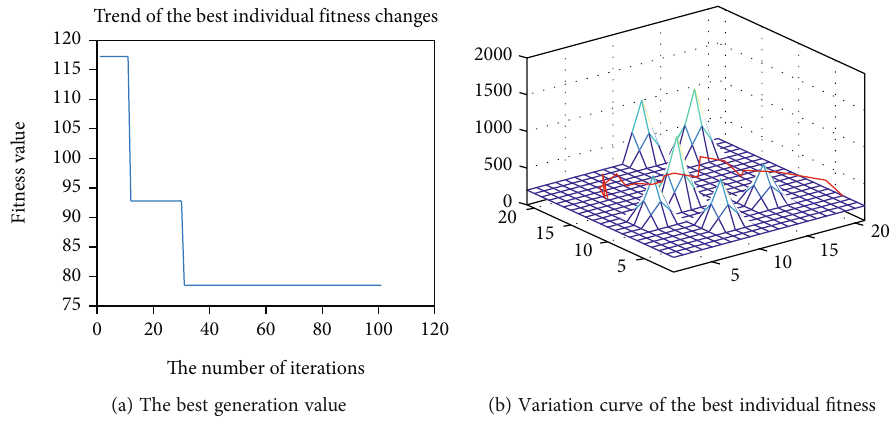
Figure 7: End one: the best generation value and path planning curve.